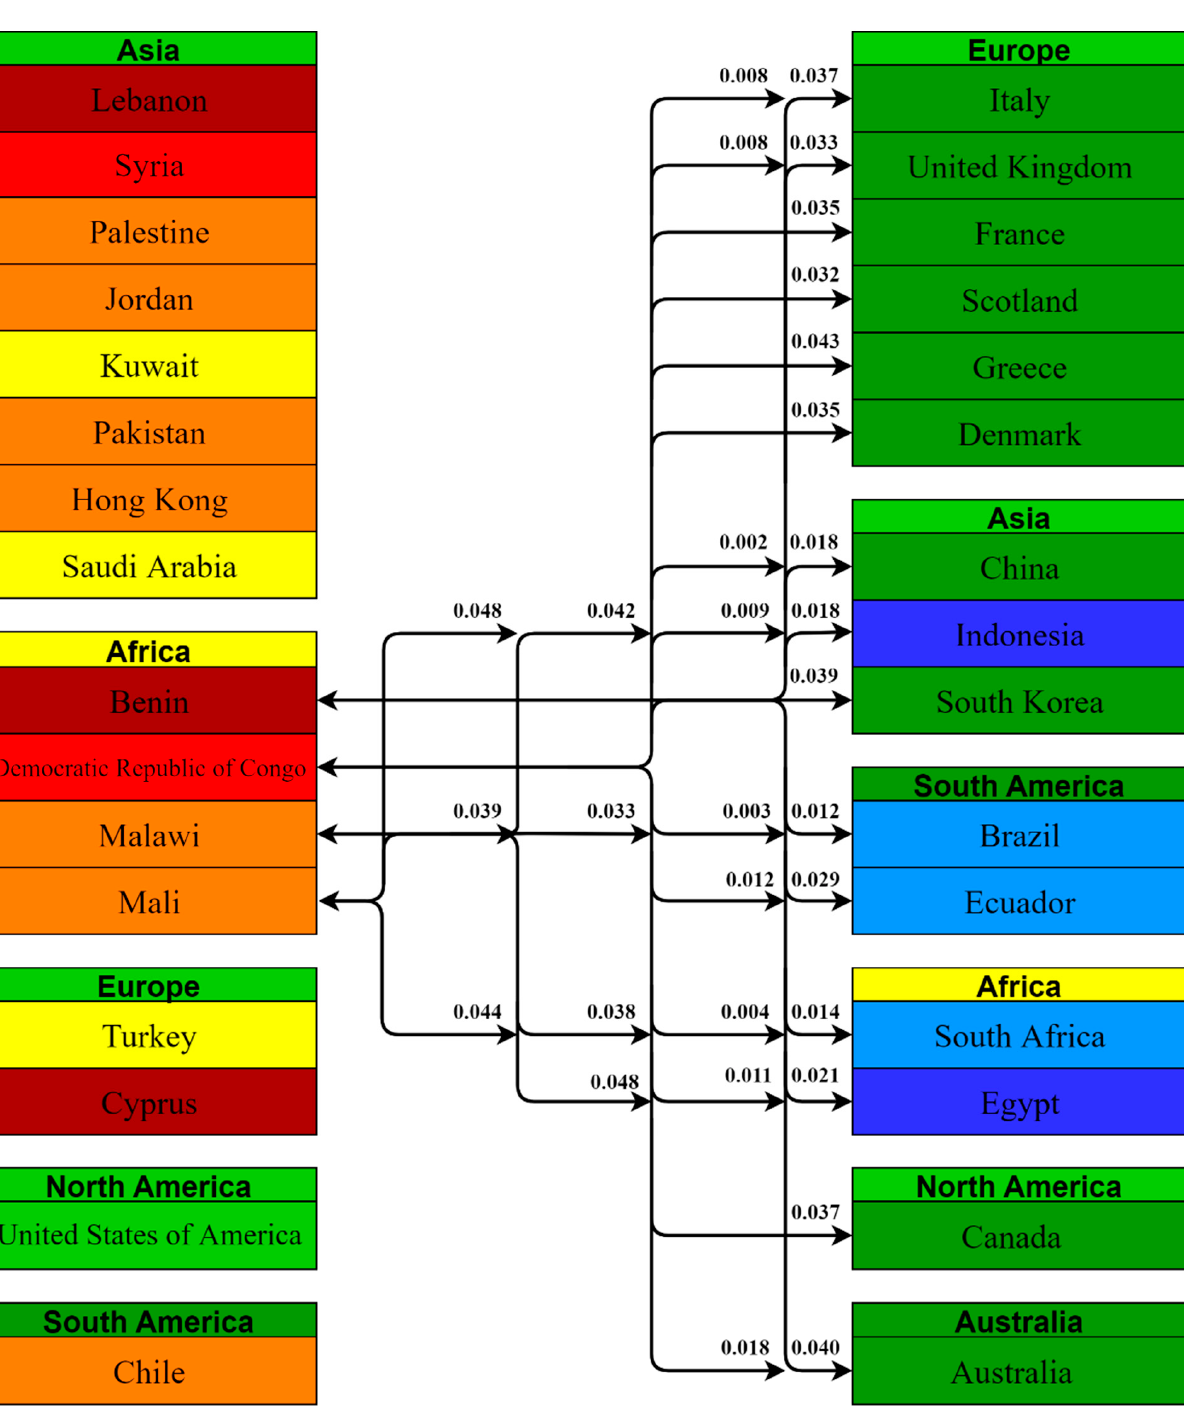
Figure 6. Pairwise comparison between African countries having lesser acceptance rates with the rest of the world and their p values.